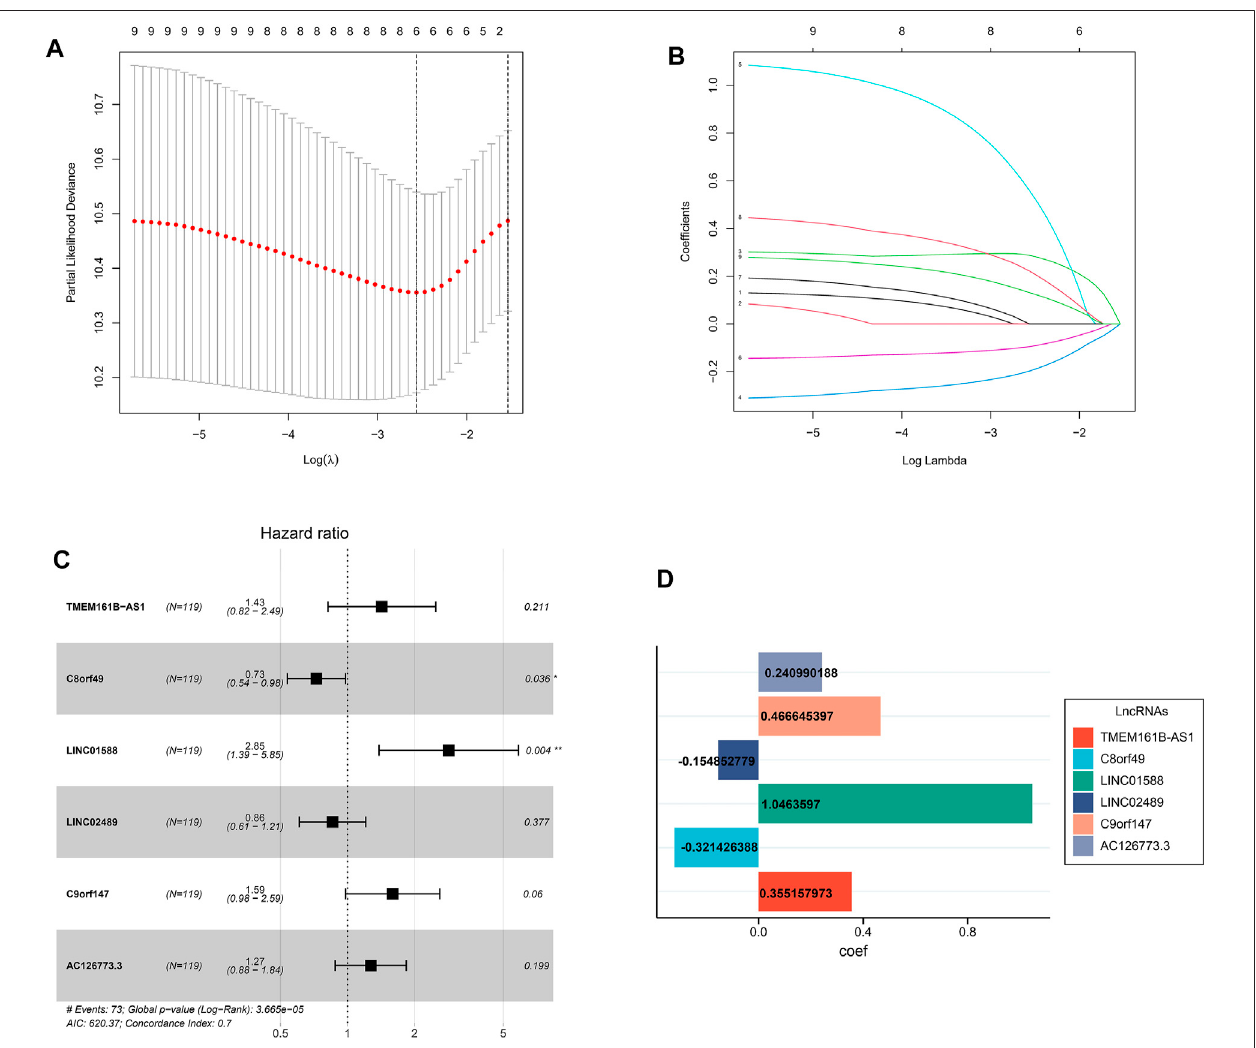
FIGURE 3 | Construction of a prognostic model. (A) Cross-validation for tuning parameter selection in the proportional hazards model. (B) LASSO coef fi cient pro fi ling of the 9 lactic acid metabolism-related lncRNAs. (C) Multivariate Cox regression analysis selected 6 lactic acid metabolism-related lncRNAs correlated with survival. (D) Multivariate cox regression analysis showed coef fi cients of each lactic acid metabolism-related lncRNAs.